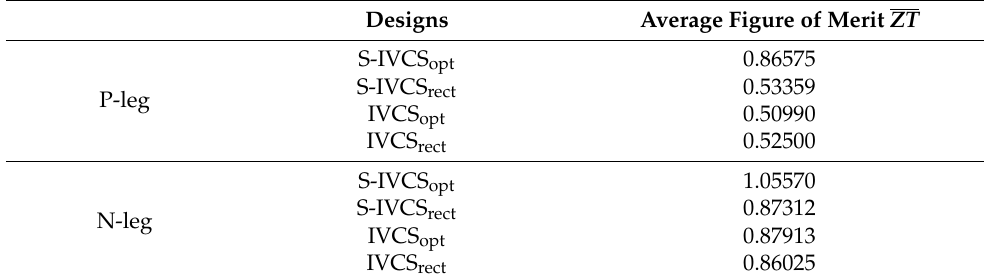
Table 5. The average figure of merit of the four designs.